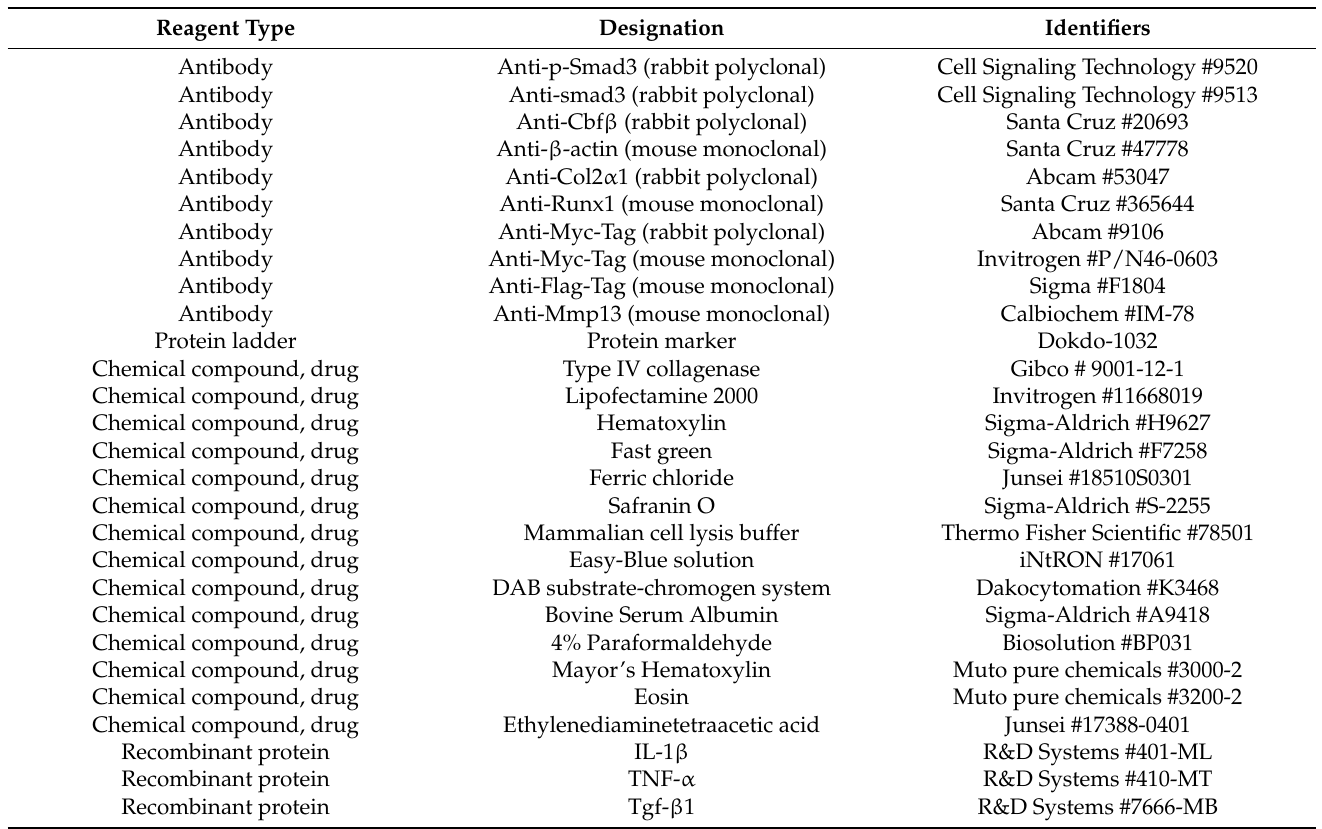
Table 1. Antibodies and